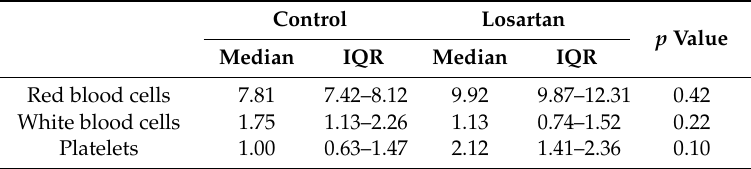
Table 1. Whole blood (WB) comparison between control and losartan groups in complete blood count (CBC) values. Red blood cells were measured in M/uL, while white blood cells and platelets were measured in K/uL.